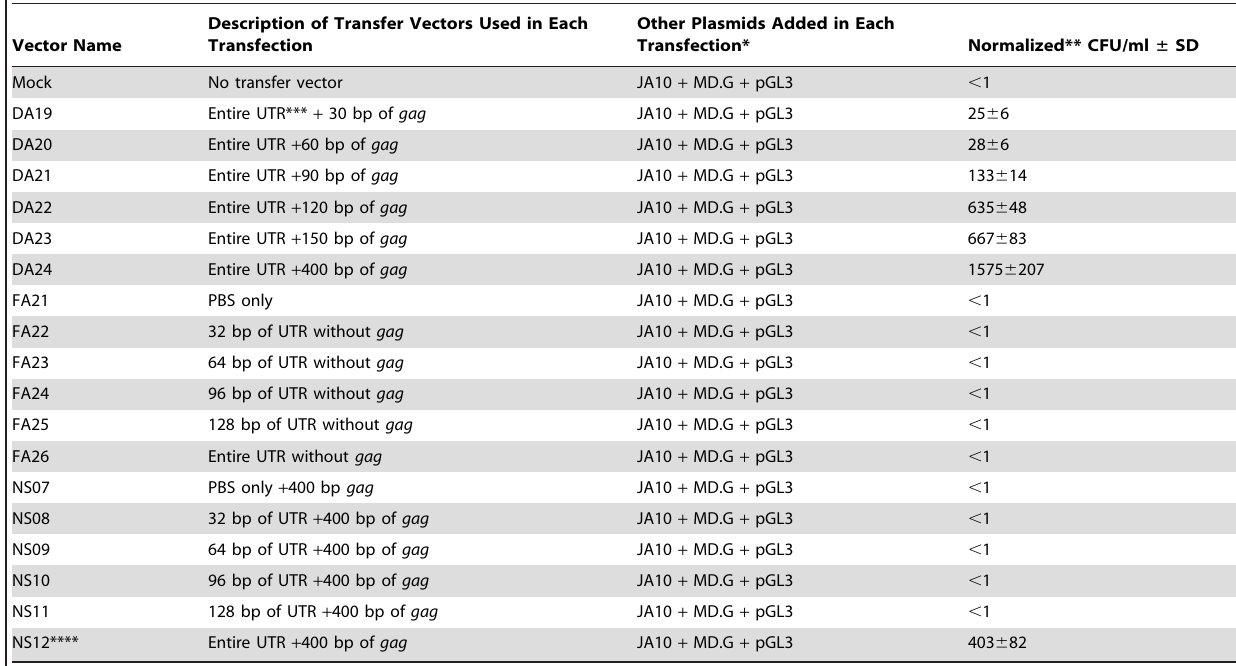
Table 1. Propagation efficiency of MMTV transfer vector RNAs containing chimeric 5 9 LTRs.